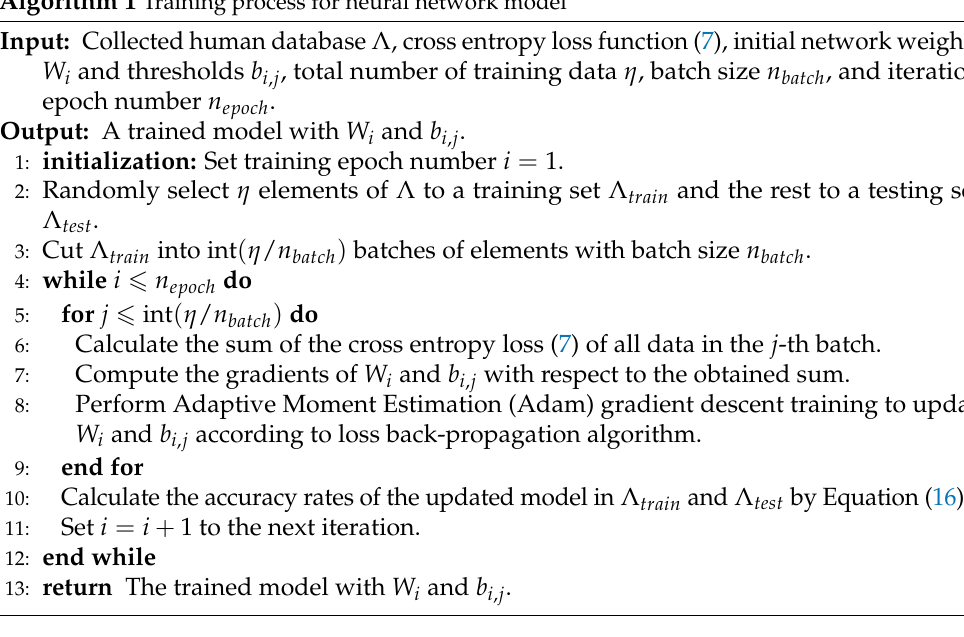
Algorithm 1 Training process for neural network